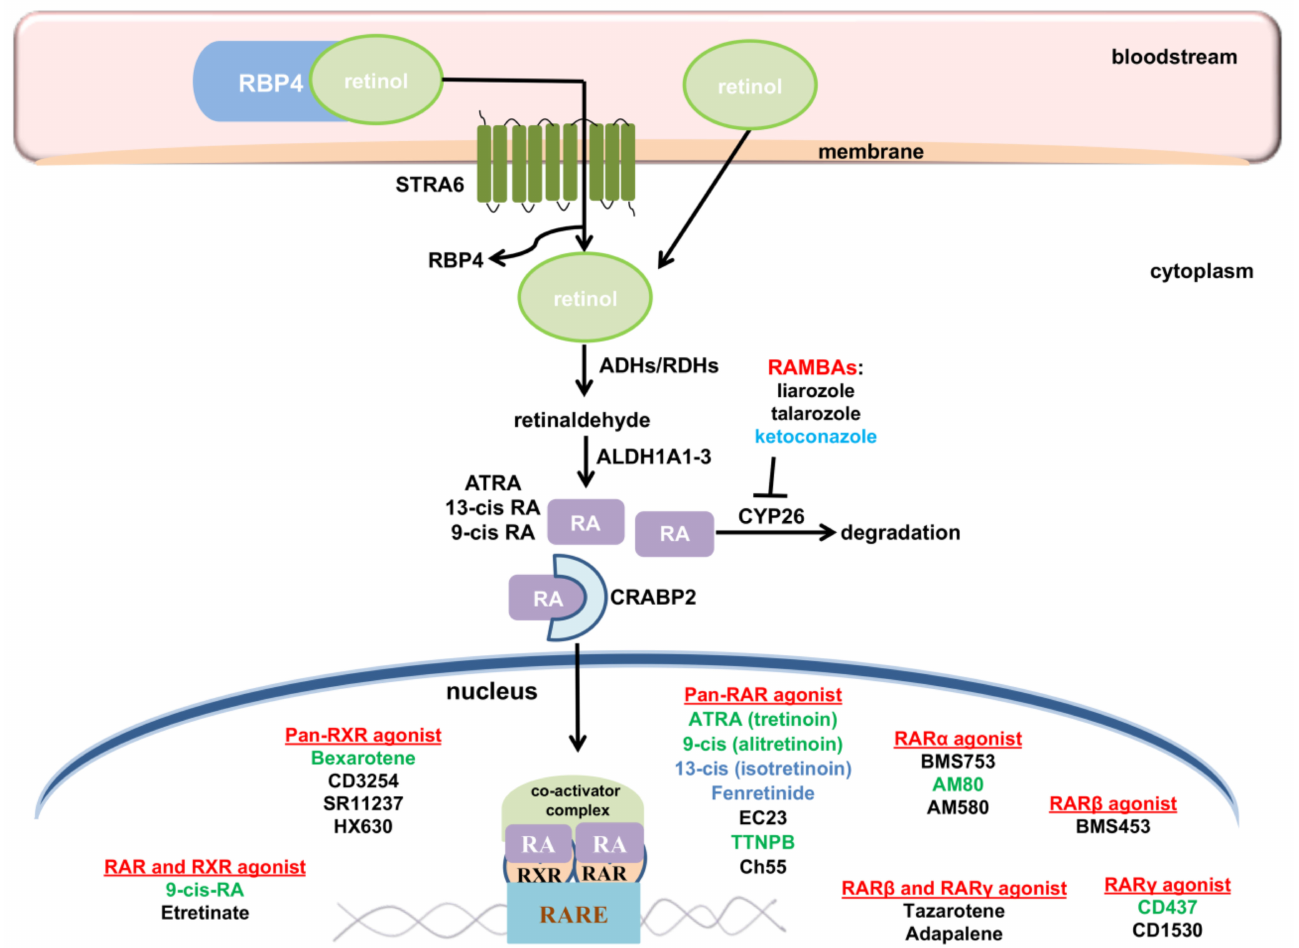
Figure 8. Overview of RA signaling pathway and RAR/RXR agonists and RAMBAs. In the bloodstream, retinol forms complex with RBP4 and enters the cells via STRA6 or by mem- brane diffusion. Within cells, retinol is converted to retinaldehyde by ADHs and RDHs and subsequently oxidized to RA by ALDH1A1-3. Three naturally occurring RA stereoisomers are ATRA, 13-cis RA and 9-cis RA. RA enters the nucleus via CRABP2, where it interacts with RAR/RXR heterodimer forming a complex that binds to RARE in the promoter regions of RA target genes. RA is inactivated by CYP26 oxidase (modified based on [380]). Summary of in- hibitors of the CYP26A1 enzyme (RAMBAs) and RARs/RXRs agonists is made based on [383] and https://resources.tocris.com/pdfs/literature/reviews/retinoid-receptors-review-2019-web.pdf (accessed on 23 May 2022), respectively. RAR and RXR agonists and RAMBAs used for treatment of GBM cells in vitro or in vivo are presented in green letters, and RAR and RXR agonists and RAMBAs used in clinical trials for GBMs are presented in blue letters, while RAR and RXR agonists and RAM- BAs not yet used in treatment of GBM are presented in black letters (based on results of previously reported publications included in the main text and results obtained by